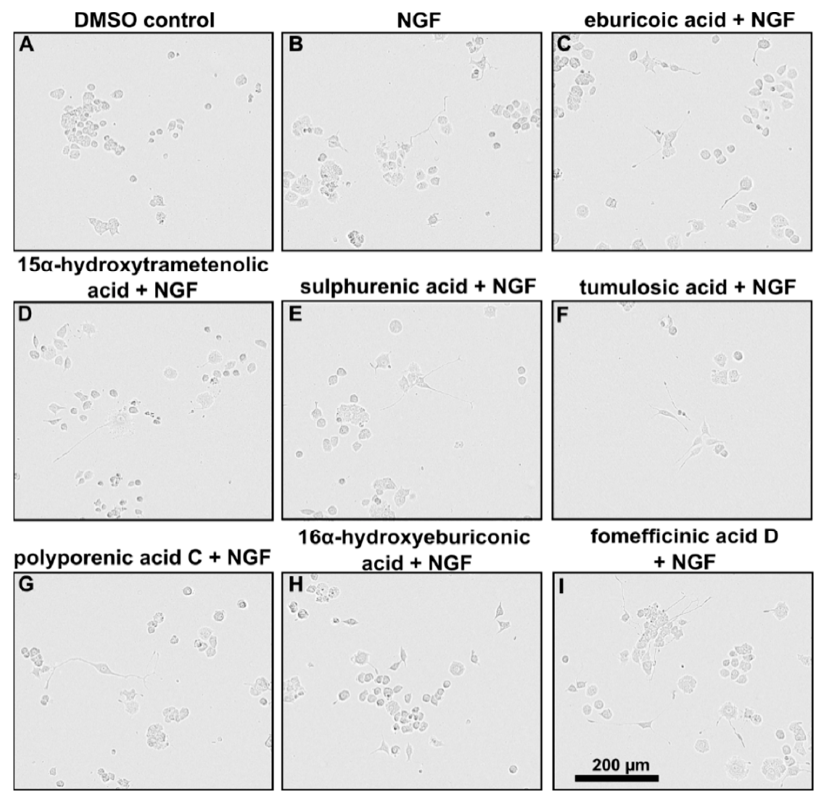
Figure 4. ( A – I ) PC-12 cells treated with 5 ng/mL ngf and either DMSO or different triterpenes (5 µg/mL) were recorded for 3 days. Phase contrast images of cells after 3 days of treatment.